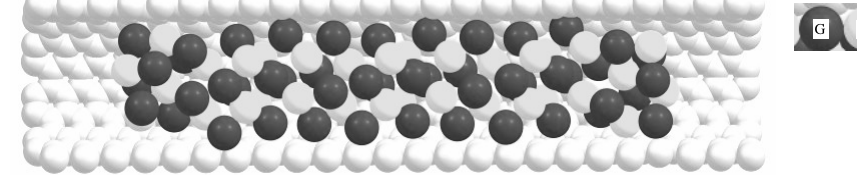
Figure 1. Model structure of Sb nanotube. (Sb-Yellow (Y), Se- Green (G)).